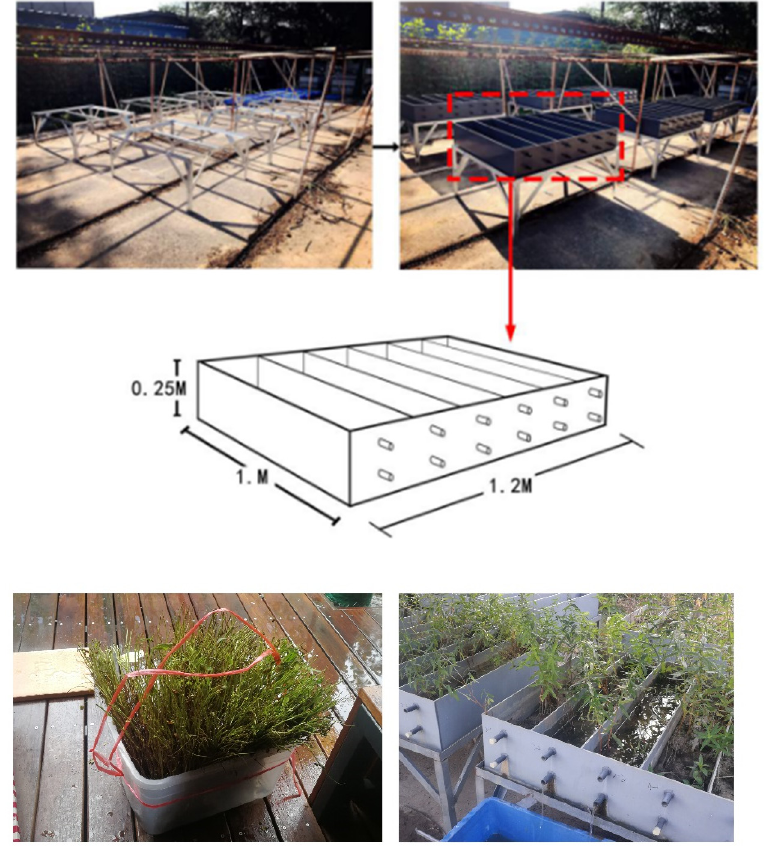
Figure 1. Diagram of